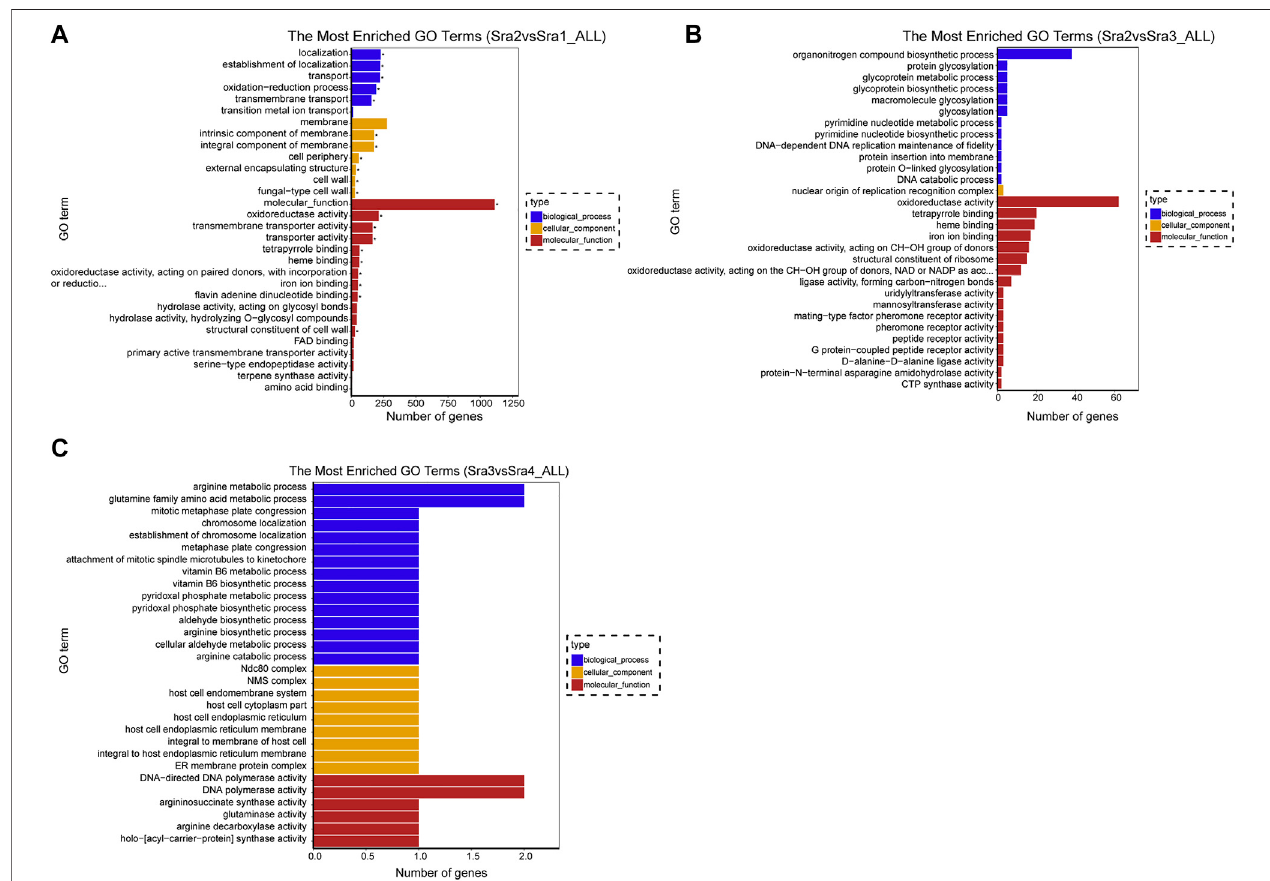
FIGURE2| GOclassi fi cationofDEGs. (A – C) GOenrichmenthistogramofthreePCGs. (A) Sra1vs.Sra2PCG; (B) Sra2vs.Sra3PCG;and (C) Sra3vs.Sra4PCG. The vertical axis was the name of the enriched GO term, and the horizontal axis was the number of DEGs in the corresponding term. Different colors were used to distinguish biological processes, cell components, and molecular functions, and “ * ” represented a signi fi cantly enriched GO term.